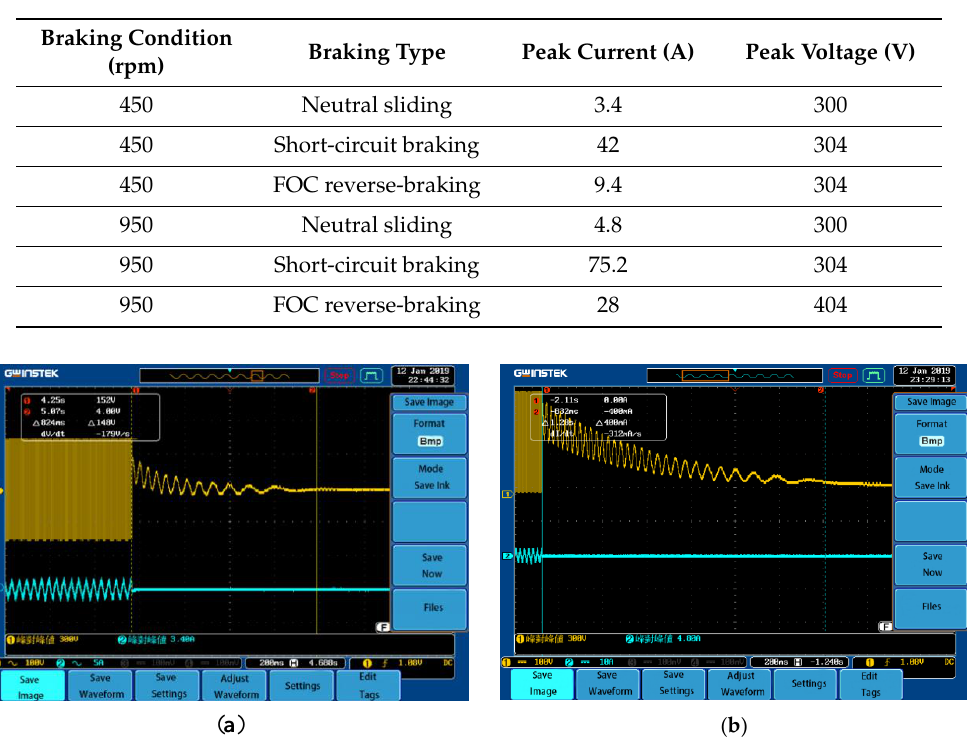
Table 2. Comparison of various braking methods.